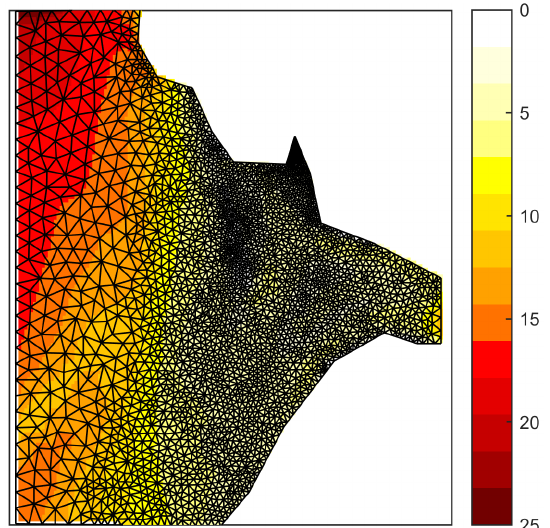
Figure 10. Bathymetry (m) of the Haringvliet Bay case projected on the triangular mesh. The minimum size of the cells is to be found in the area around the Hinderplaat